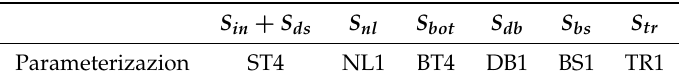
Table 1. Source term treatment in